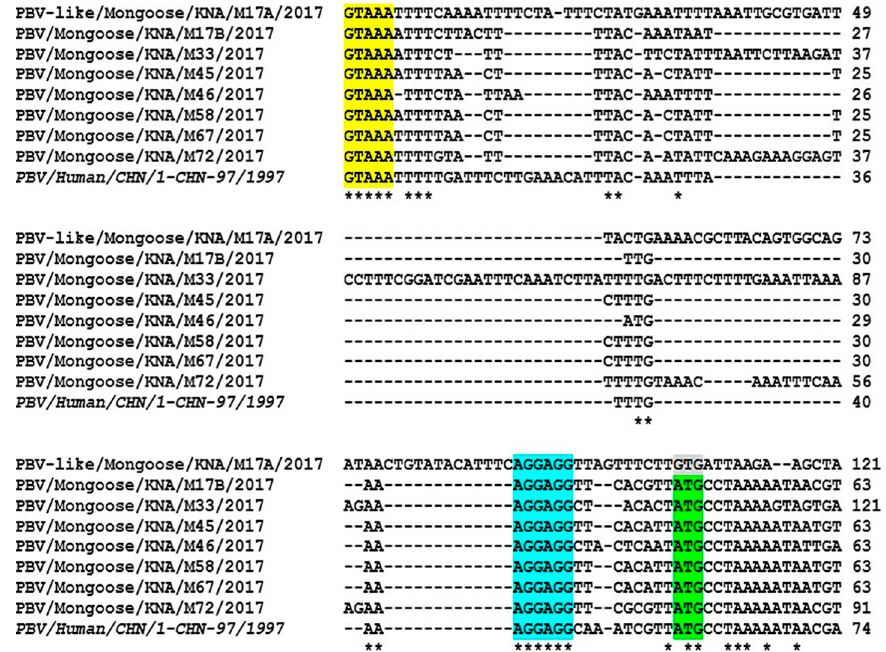
Figure 3. Alignment of the 5 ′ - region of the mongoose PBV and PBV-like RNA-dependent RNA polymerase (RdRp) gene sequences with that of prototype PBV GI strain PBV/Human/CHN/1-CHN- 97/1997 (indicated with italic type ). The 5 ′ - terminal sequence (highlighted with yellow) and the bacterial ribosomal binding site (RBS) sequence (highlighted with blue) that are conserved in gene segment-2 of PBVs were retained in the mongoose PBV and PBV-like RdRp sequences. The putative start codon (ATG) for RdRp in gene segment-2 of mongoose PBV GI strains has been highlighted with green, whilst the putative alternative initiation codon (GTG) for RdRp in the novel PBV-like sequence (M17A) is shown with gray. A ‘*’denotes an identical nucleotide (nt) residue, whilst ‘-’ indicates absence of nt residue. Numbers to the right indicate the positions of the nt for respective PBV strains. Alignment of the complete/nearly complete mongoose PBV and PBV-like RdRp gene sequences with that of the prototype PBV GI strain is shown in supplementary material S4.